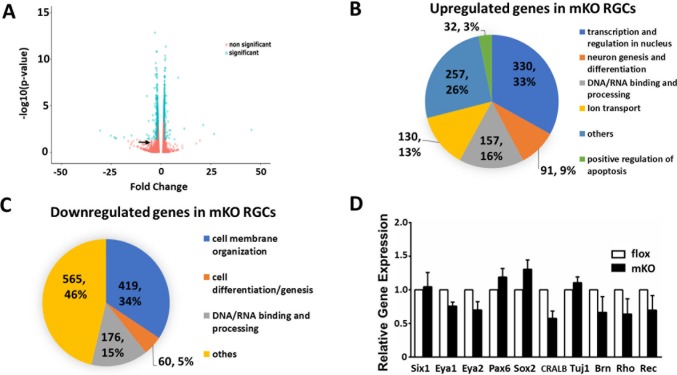
Gene Ontology analysis for differentially expressed genes in WT and mKO mice.(A) Volcano plot showing fold changes (fc) of all genes detected from RGCs of mKO mice against control mice. Statistical significance (green dots) was defined as P <0.05 with a fold change ≥ +1.5 or ≤ -1.5 when compared to WT; non-significant changes (orange dots) fulfill either one or none of these two criteria. 997 genes were found with fc ≥ +1.5 and 1,220 genes with fc ≤ -1.5. Arrow points to the Ezh2 site. (B,C) Pie charts represent depicted GO terms for upregulated (B) and downregulated (C) genes with │fc│ ≥ 1.5. No GO term in either up- or downregulated gene group were found to be specifically related to eye development. (D) RT-PCR verification of mRNA levels of retinal related genes in RGCs purified from P5 floxed littermate control (white bar; n = 4) and mKO (black bar; n = 7) mouse pups. CRAL: Cellular retinaldehyde binding protein; Tuj1: βIII-tubulin (Tubb3); Brn: Brn3a (Pou4f1); Rho: Rhodopsin; Rec: Recoverin (*P < 0.05 by one-way ANOVA).